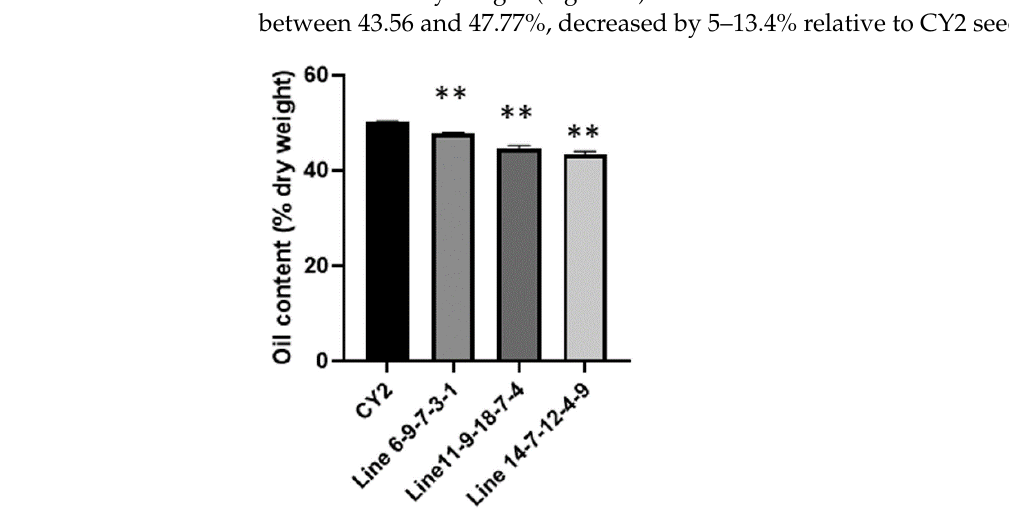
of the oil content by the Soxhlet method. Values are means ± SE ( n = 3). Asterisks indicate statistically